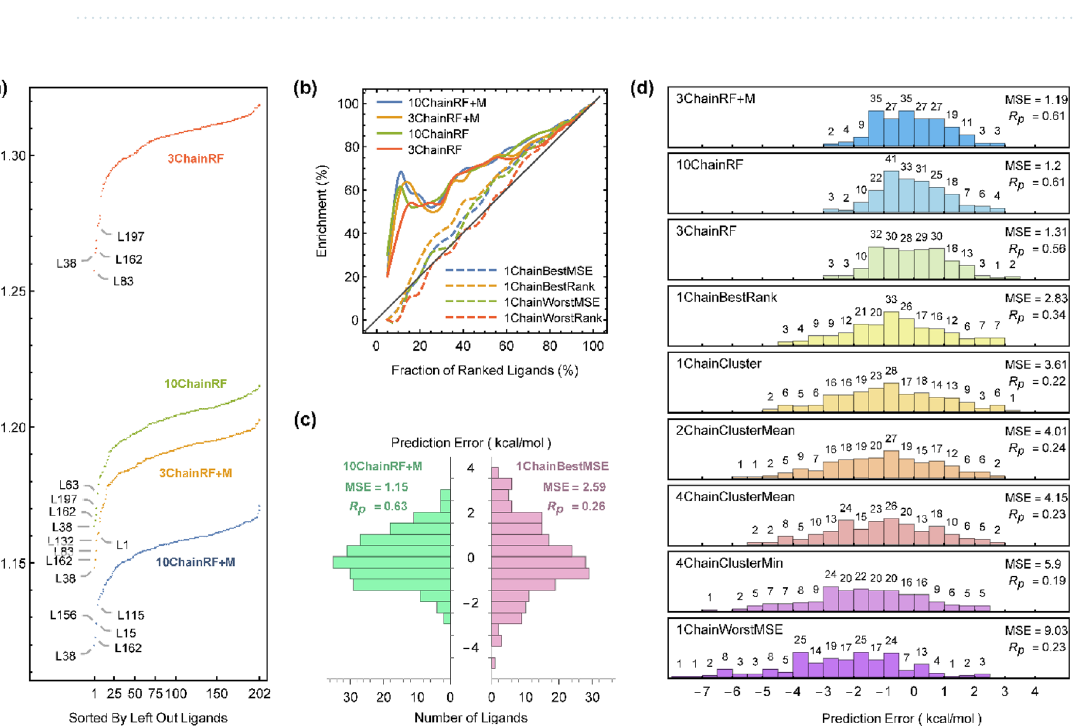
Table 1. Different models and their performance measures. In the case of single receptor and ensemble docking models, metrics were obtained from docking predictions, and in the case of RF models, leave-one- out prediction errors were used. EFx% corresponds to the percentage of the top x% of experimentally ranked ligands that correctly predicted in the top x% of computationally ranked ligands.